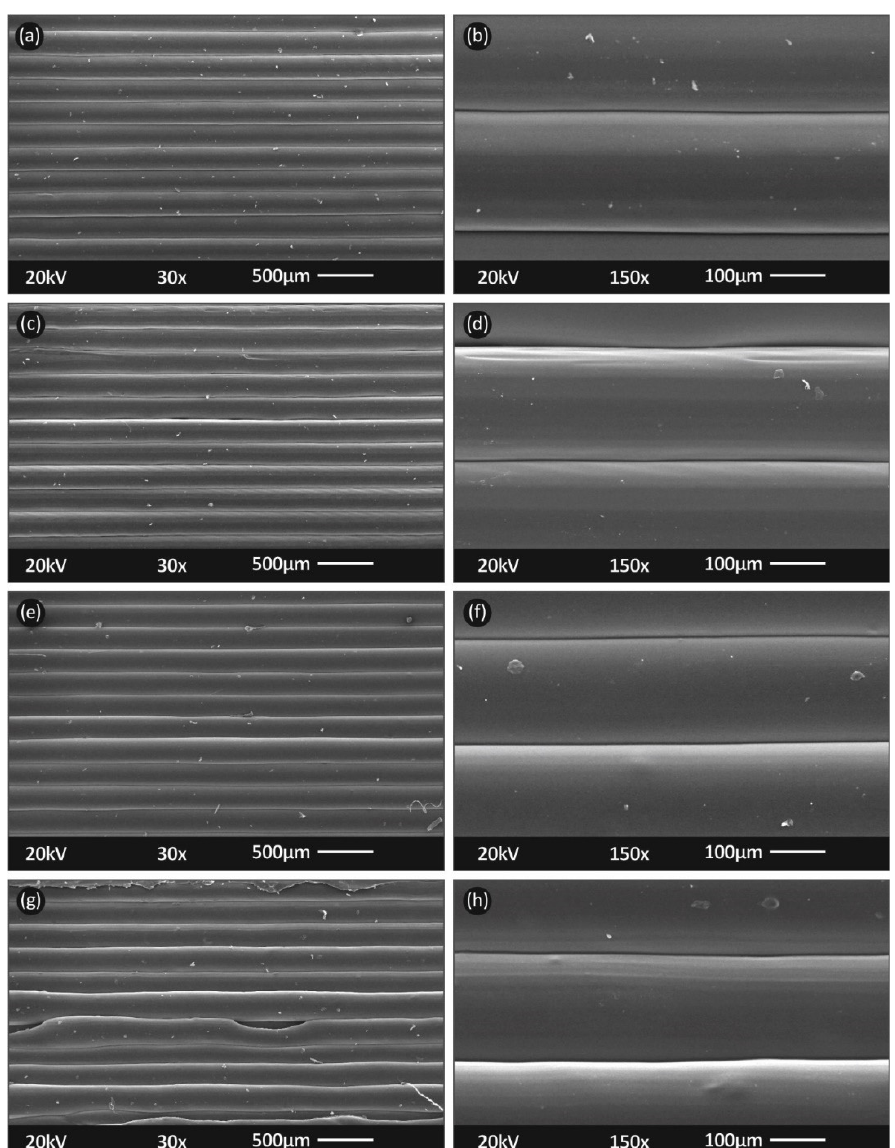
Figure 5. Side surface morphology of 3D printed tensile test specimens of neat PLA ( a , b ), as well as PLA/CB with 0.5 wt.% ( c , d ), 2.5 wt.% ( e , f ) and 5.0 wt.% ( g , h ) CB filler loading.